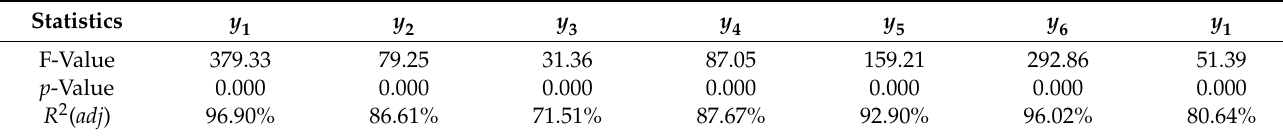
Table 4. The main ANOVA results of the responses y 1 – y 7